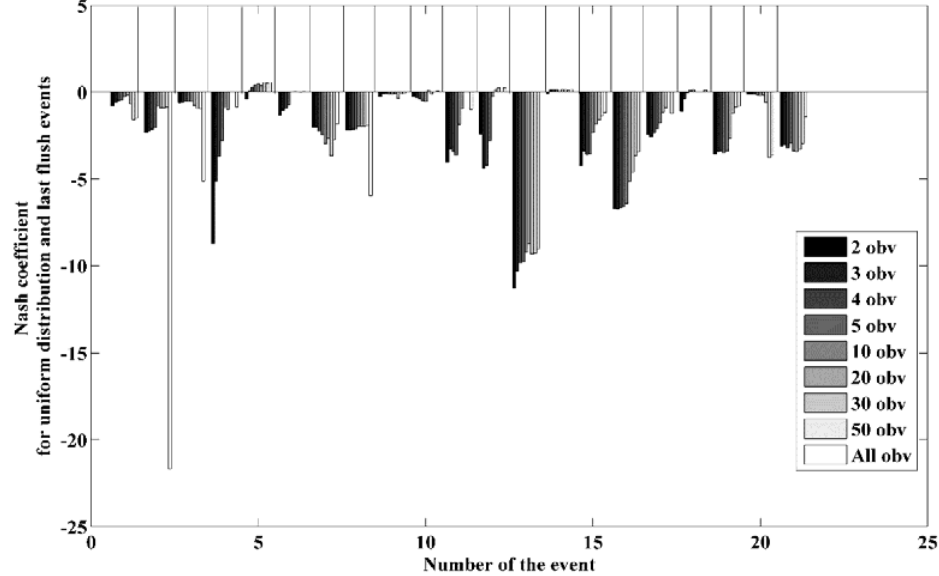
Figure 15. Bar plot of the Nash–Sutcliffe coefficients calculated for uniformly distributed and last flush events.